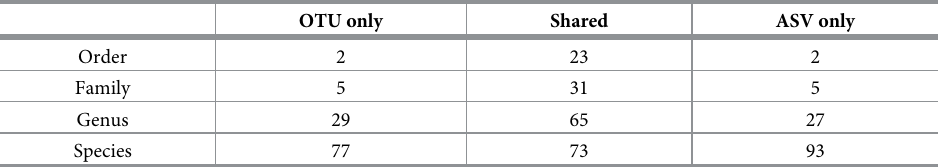
Table 2. Comparison of the annotation ability of the OTU clustering method with the ASV